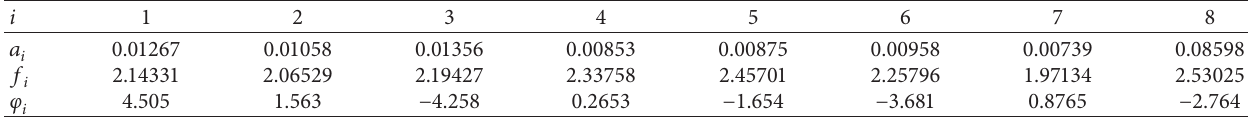
Table 3: Values of 24 fitting parameters in equation (1) in 40 ∼ 60s.